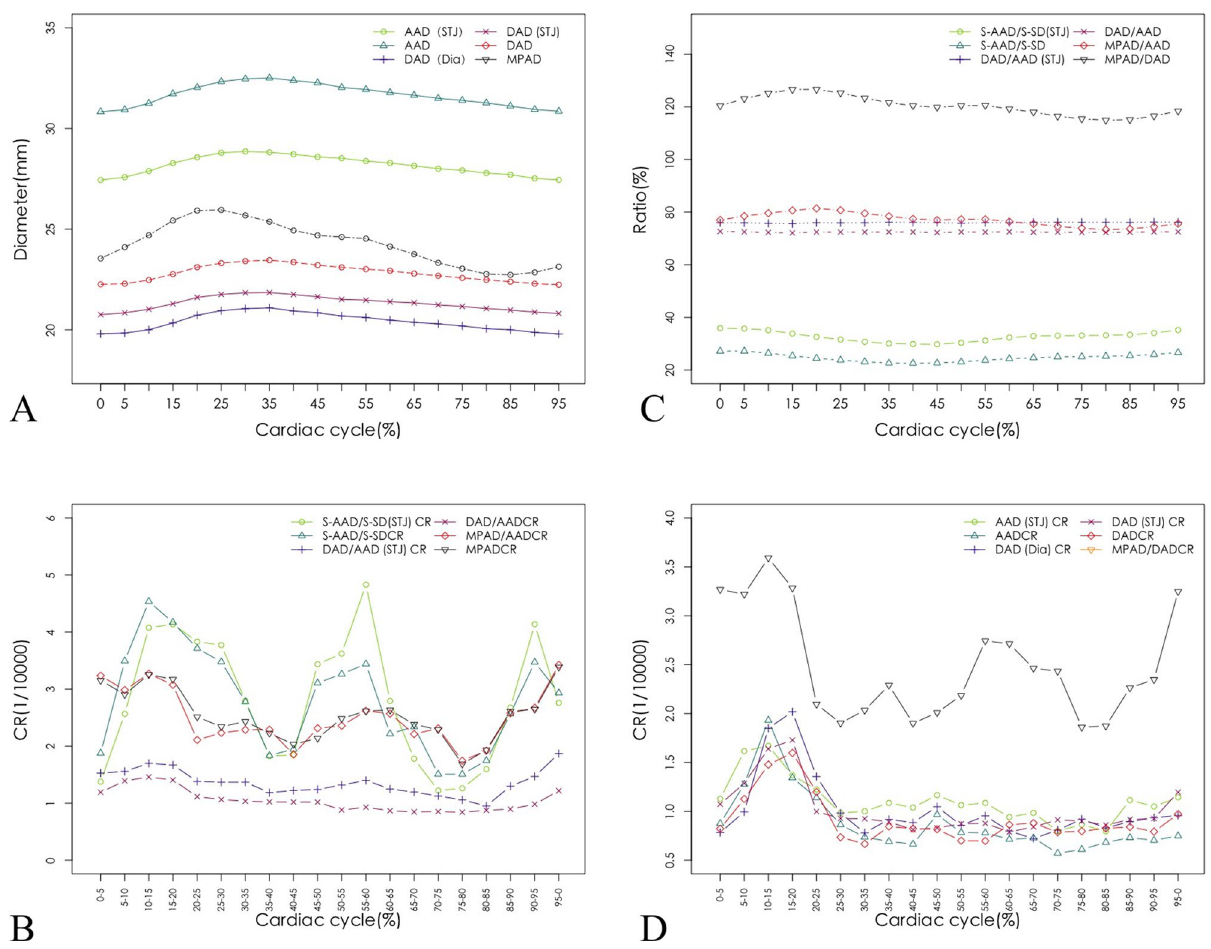
Figure 1. Relationship between aorta and cardiac cycle (with R (Version 3.6.1, R Core Team, 2019) software. URL: https:// www.r- proje ct. org/). ( A ) The relationship between aortic diameter and cardiac cycle, ( B ) the relationship between the change ratio of aortic diameter and cardiac cycle, ( C ) the relationship between aortic ratio and cardiac cycle, ( D ) the relationship between the change ratio of aortic ratio and cardiac cycle.